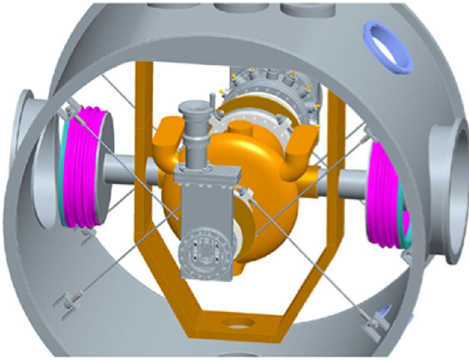
FIG. 20. Hermetic string inserted into the vacuum vessel.